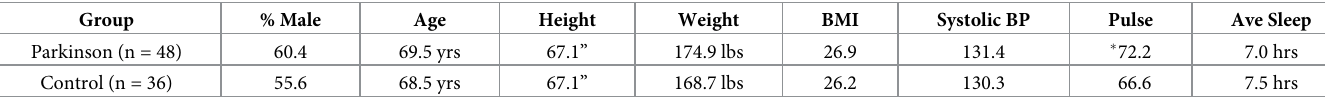
Table 1. Subject demographic and clinical